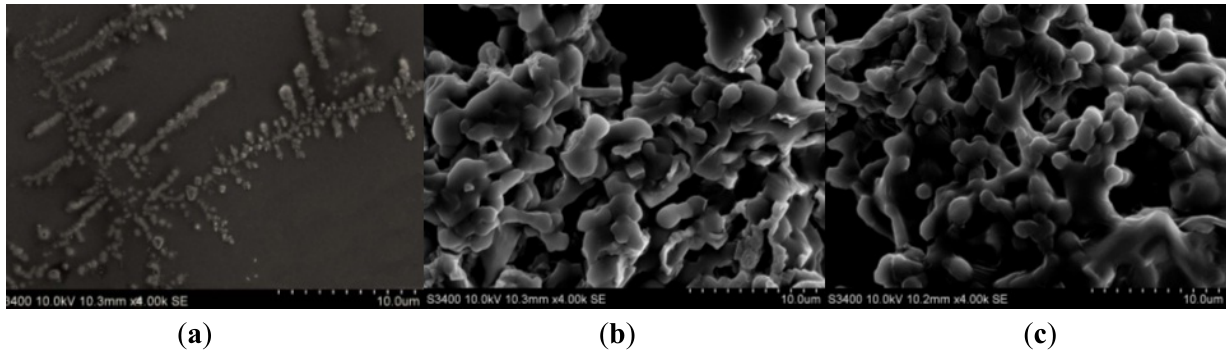
O @SiO (MNPs) 3 4 2